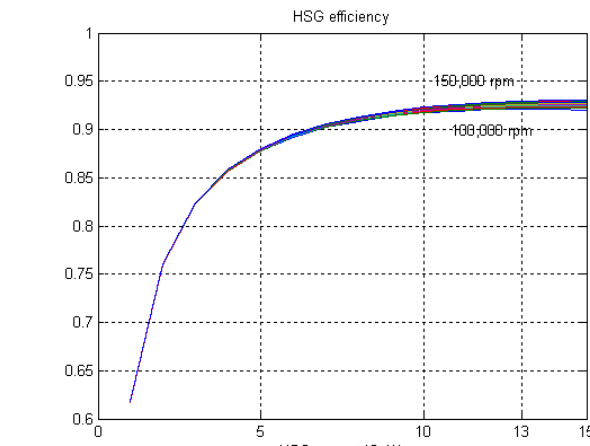
Figure 13. ( a ) Total efficiency (net grid electric power/input mechanical power) as a function of the generator current IG varying the MGT speed from 100 to 150 krpm; ( b ) Total calculated efficiency as a function of net grid output Power P4 varying the MGT speed from 100 to 150 krpm.